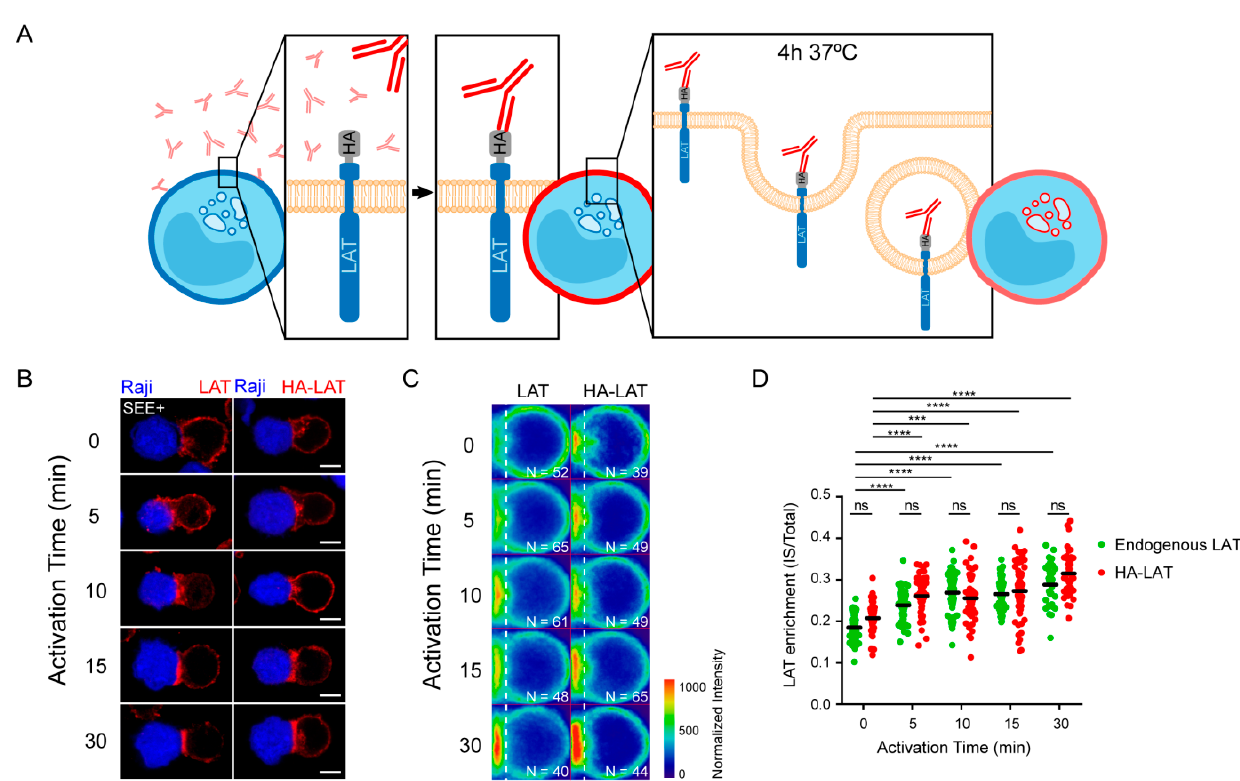
Figure 1. Total and endocytosed LAT are recruited to IS with similar kinetic. ( A ) Endocytosed LAT assay: Jurkat cells expressing a chimeric LAT protein tagged in its extracellular domain with HA (HA-LAT-Jurkat) were labeled at 4 °C for 30 min with a mouse anti-HA Ab, washed and then incubated at 37 °C for 4 h to allow LAT endocytosis. ( B ) Confocal images showing total (left panel) or endocytosed LAT (right panel) recruitment at the immune synapse (IS). Non-transduced Jurkat or HA-LAT-Jurkat cells after endocytosed LAT assay, were activated with SEE pulsed Raji B cells at different time points. Immunolabelings were performed using anti-mouse Ig (Alexa Fluor 568) to label the anti-HA Ab or anti-LAT to label total LAT. ( C ) Average cell representation and ( D ) quantification of the enrichment of total and endocytic LAT at the immune synapse (depicted by the dotted white line) in Jurkat T cells interacting with Raji B cells and activated with SEE for different time points. n = number of cells constituting the mean image. Horizontal lines represent the median. Scale bars = 5 µ m. Two-way ANOVA *** p < 0.001, **** p < 0.0001, ns: nonsignificant. Data and images are from two independent experiments in ( B ), ( C ) and ( D ).